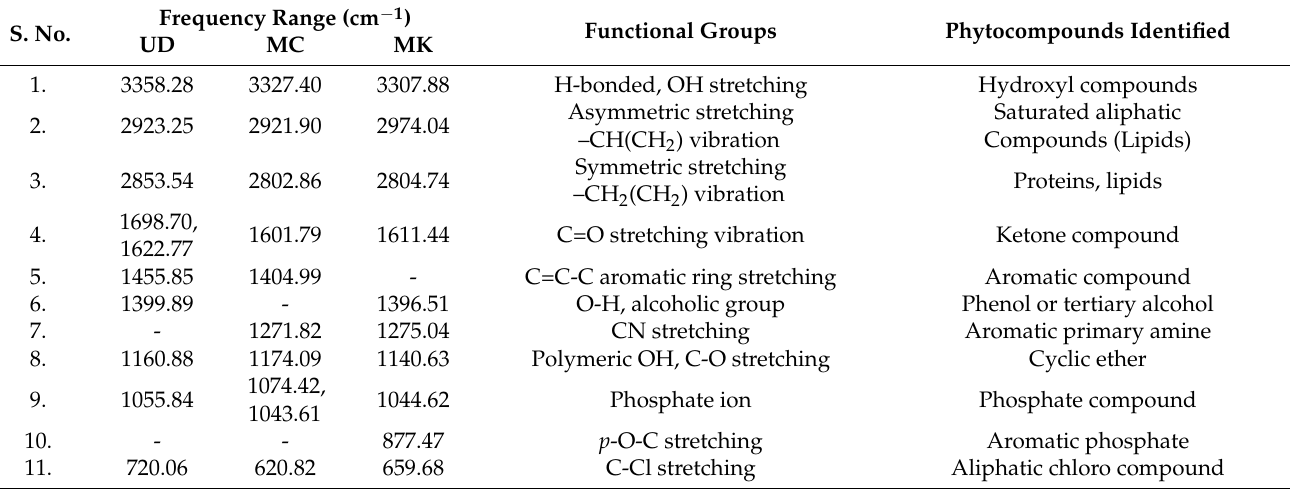
Table 5. FT-IR frequency range and functional groups are present in the extracts of UD, MC, and MK. S.